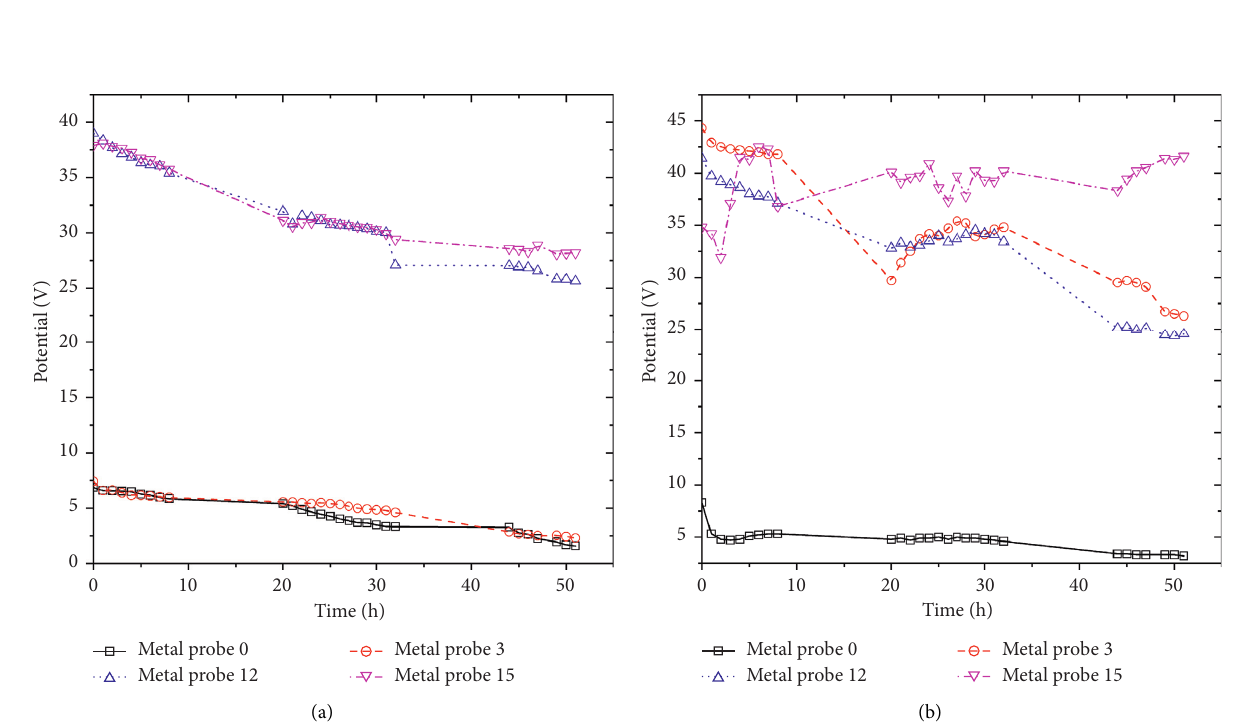
Figure 5: Electrode potential change curve. (a) Symmetrical unit model. (b) Asymmetrical element model.